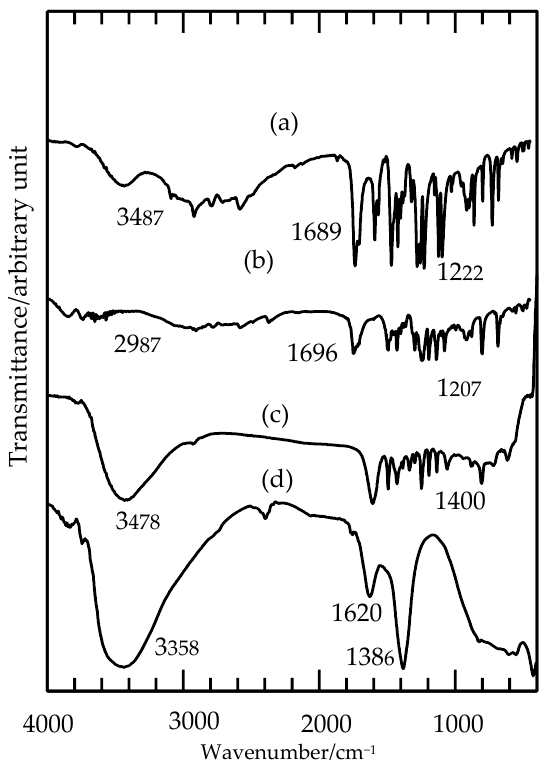
Figure 5. FTIR spectra of the guest anions ( a ) 3,4D, ( b ) TBA, ( c ) ZADTX and ( d ) LDH.